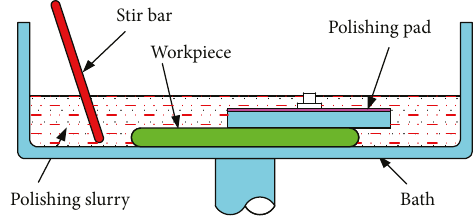
Figure 1: Bowl feed polishing